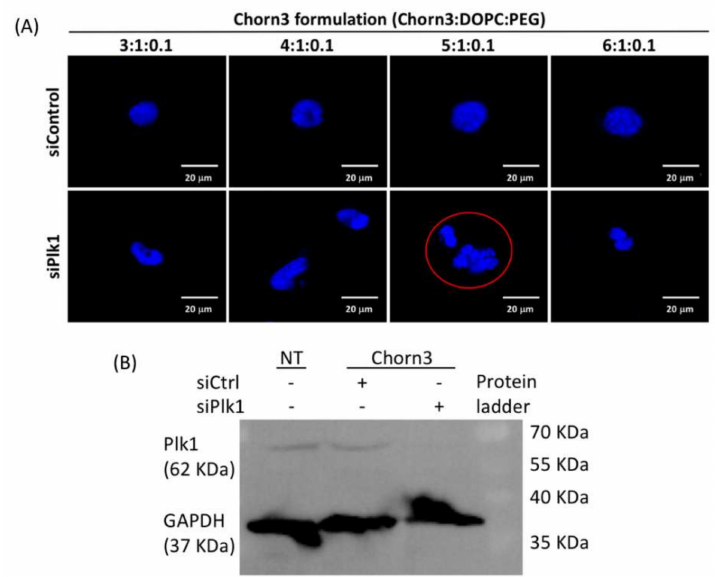
Figure 8. Chorn3 mediated delivery of siRNA against polo-like kinase 1 (Plk1) in HeLa cells. ( A ) Confocal images showing segregation of nuclei (red circle) induced by RNA interference (RNAi) mediated silencing of Plk1 gene. ( B ) Western blotting showing significant decrease of Plk1 protein in cells transfected with siPlk1 / Chorn3